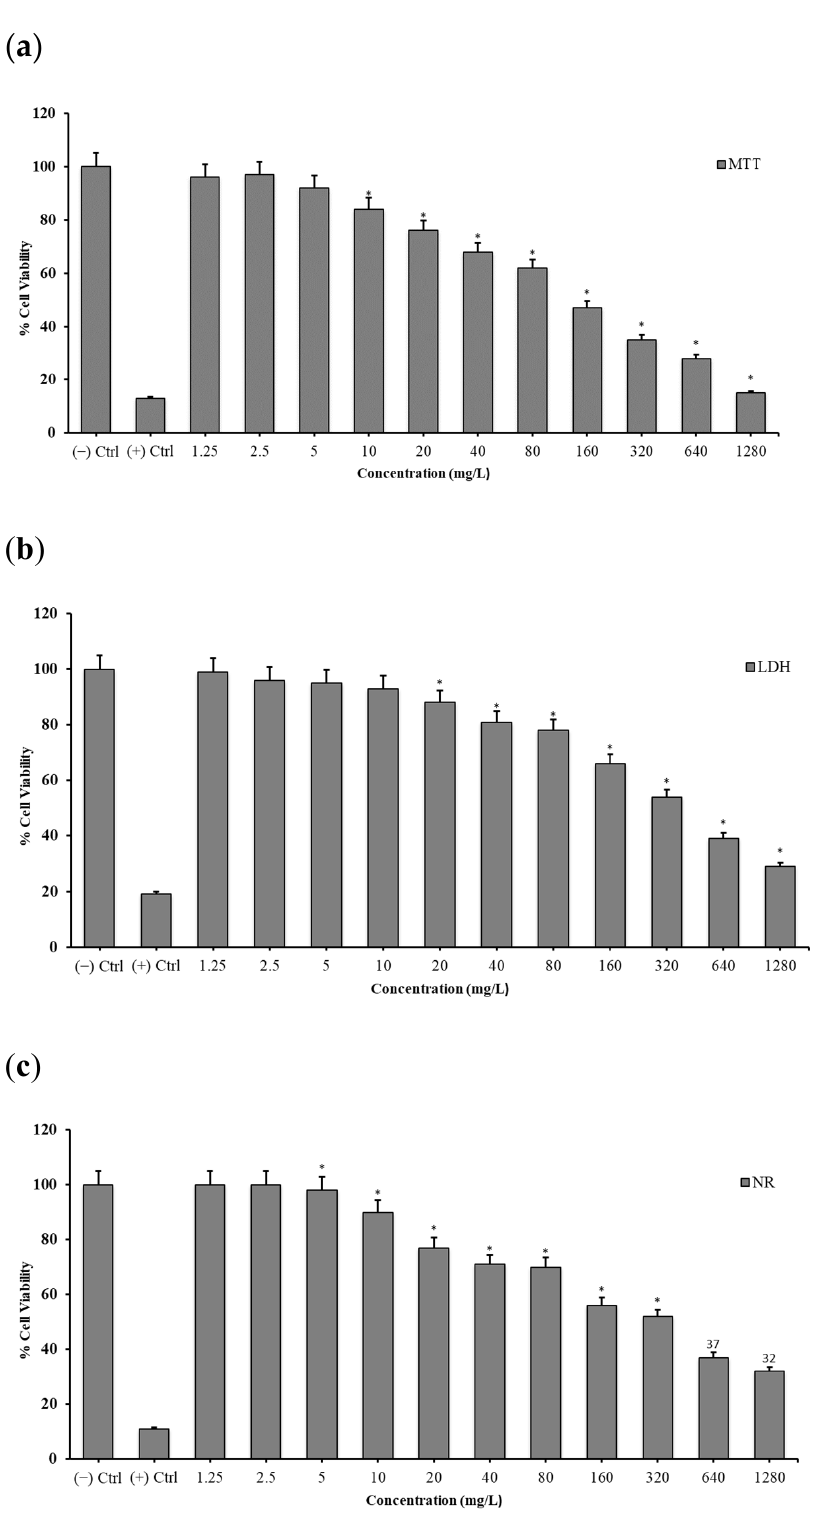
Figure 4. Cell viability assay of zinc borate (Zn 3 BO 6 ) NPs on human pulmonary alveolar cells. ( a )— 3-(4,5-Dimethylthiazol-2-yl)-2,5-diphenyltetrazolium bromide (MTT) cell viability analysis of Zn 3 BO 6 NPs, ( b )—lactate dehydrogenase (LDH) cytotoxicity analysis Zn 3 BO 6 NPs and ( c )—neutral red (NR) cell viability analysis of Zn 3 BO 6 NPs on human pulmonary alveolar cells. * SPSS program (SPSS ® , USA), Duncan’s test was performed for each experiment for statistical calculations at a significance level ≤